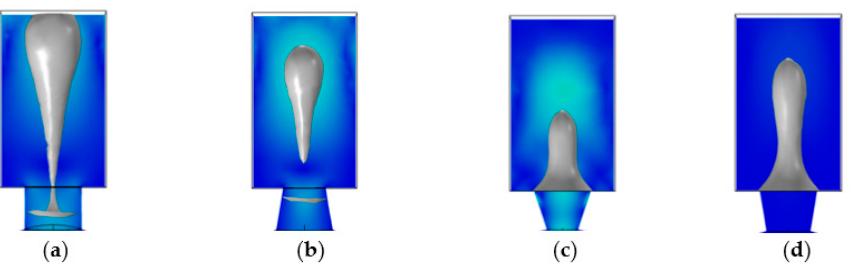
Figure 8. The broken state of the liquid column under different nozzles. ( a ) The broken state of the liquid column in the straight nozzle; ( b ) The broken state of the liquid column in the conical shrinkage nozzle; ( c ) The liquid column was broken when the conical diffusion nozzle’s bottom diameter was 10 µ m; ( d ) The liquid column was broken when the conical diffusion nozzle’s bottom diameter was 15 µ